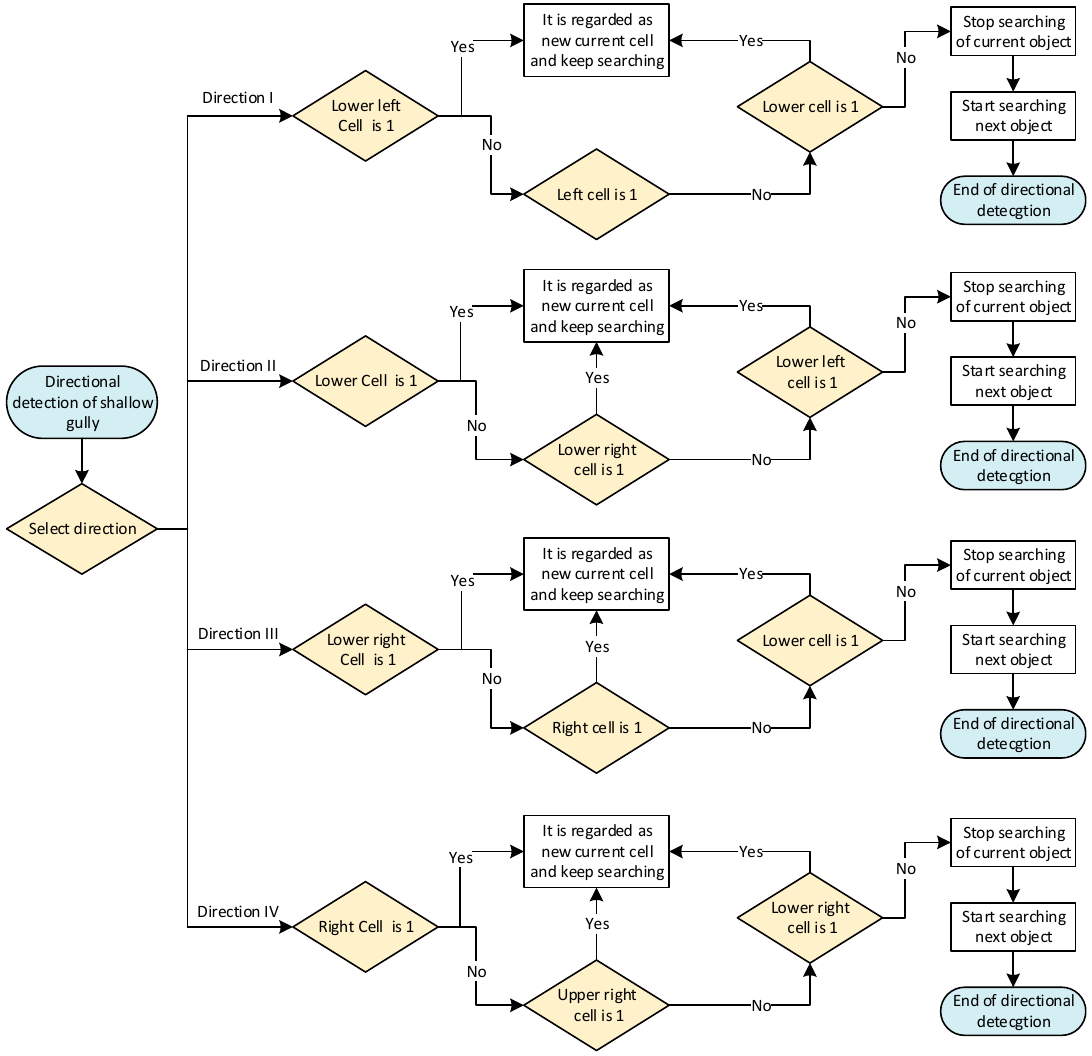
Figure 7. Directional searching rules of four typical directions.